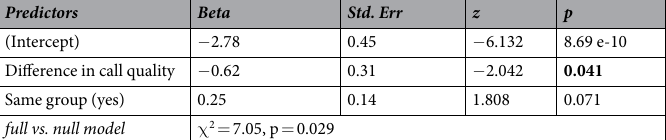
Table 3. Results from General Linear Mixed Model